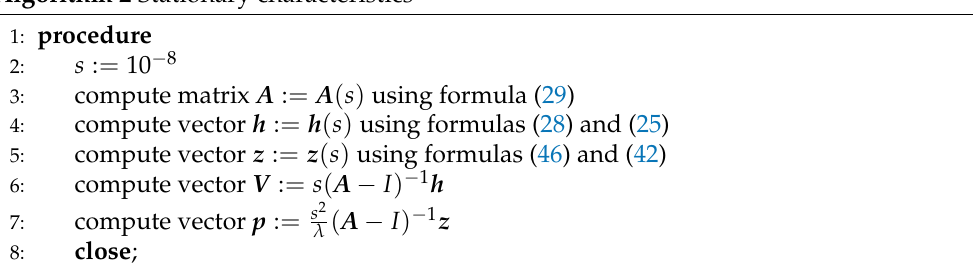
Algorithm 2 Stationary